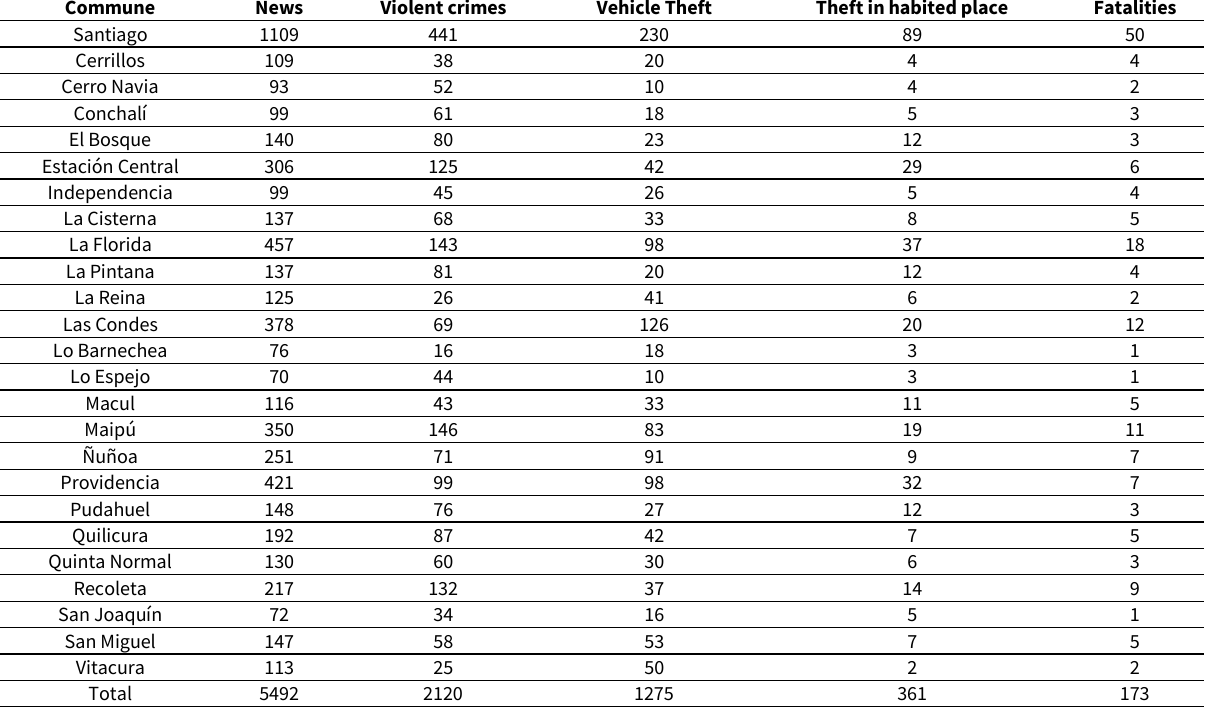
Table 1. Summary of events by geographical